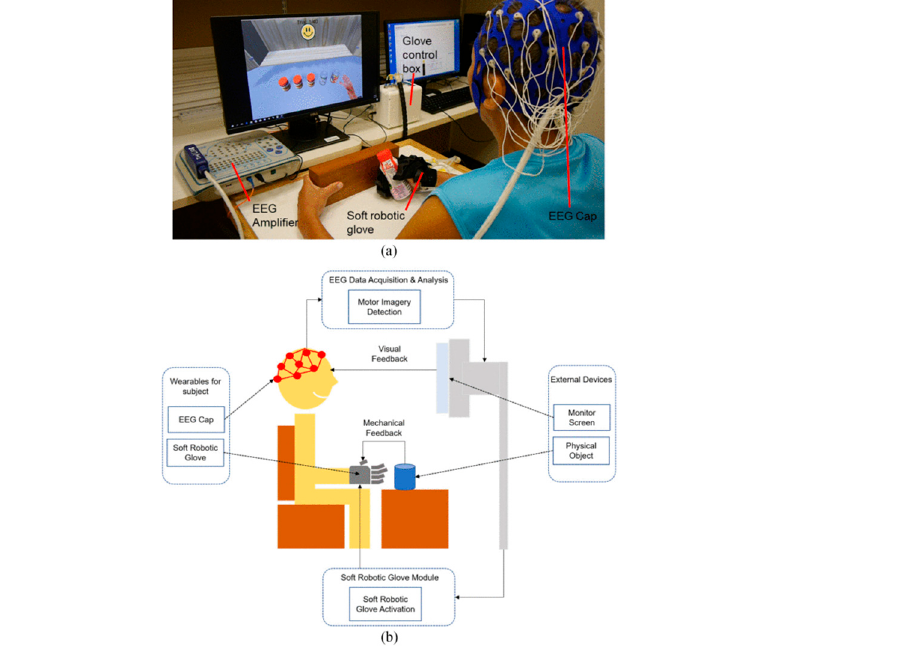
Figure 10. The setup of BCI-assisted soft robotic glove for stroke rehabilitation at ( a ) a local hospital, with ( b ) depicting an illustrated overview. The setup comprises a EEG cap, EEG amplifier, and soft robotic glove. Adapted with permission from Ref. [101]. 2022, Cheng N et al.